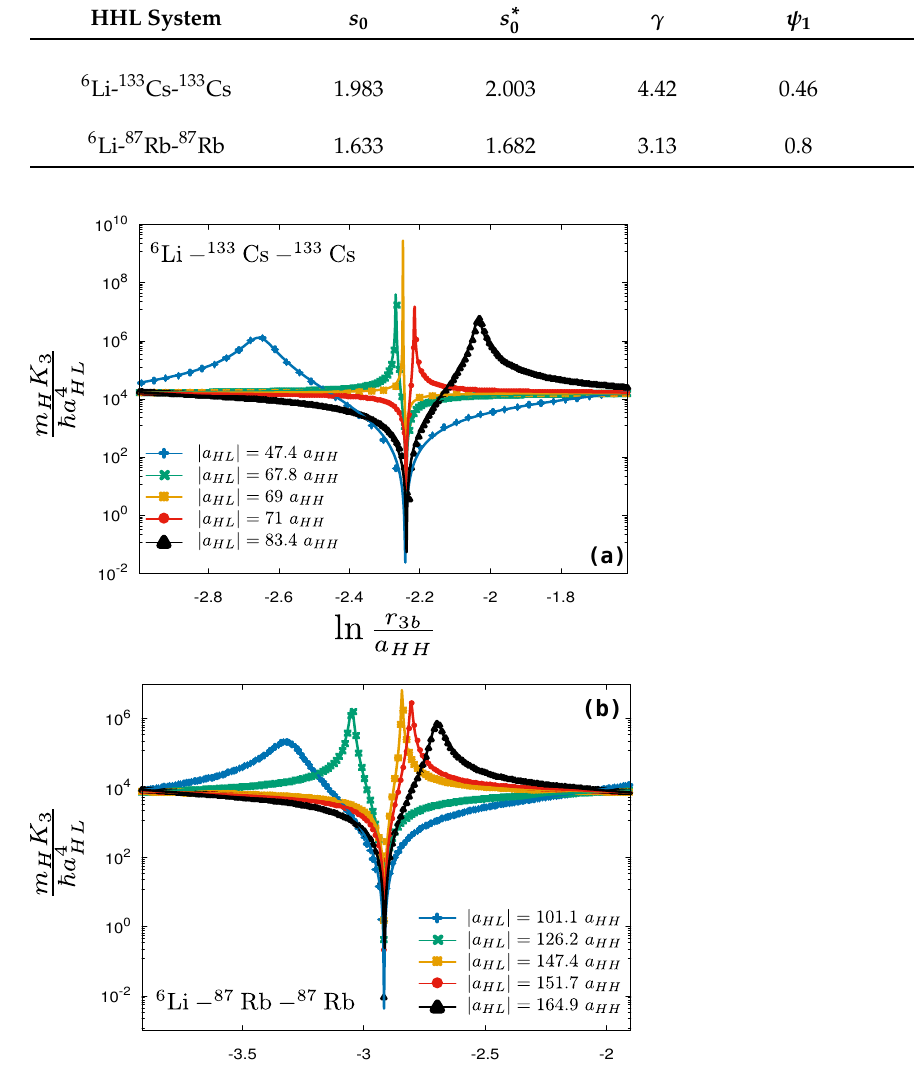
Table 1. A summary of the universal parameters used in Equations (16)–(18) for the systems of 6 Li − 133 Cs − 133 Cs and 6 Li − 87 Rb − 87 Rb. Note that the values of s